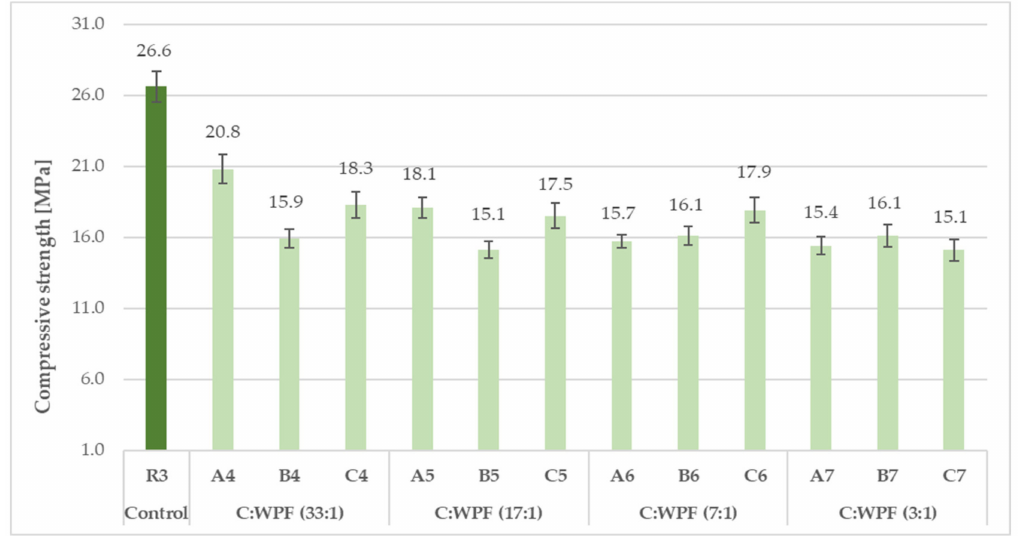
Figure 16. Compressive strength of fiber-cement mortars with different C/WPF ratios (set II). As the C/WPF ratio decreased, the values of the compressive and flexural strength of the fiber-cement mortars decreased significantly. The fiber-cement mortars reached values of compressive and flexural strength in the range of 15.1–32.7 MPa and 3.01–5.92 MPa, respectively, depending on the WPF content, and they represented a lower level of the strength parameter found for reference samples R2 and R3. The higher the bulk density, the higher the value of the compressive strength of the fiber-cement mortar depending on the WPF content of sample C is observed (Figure 19; R =